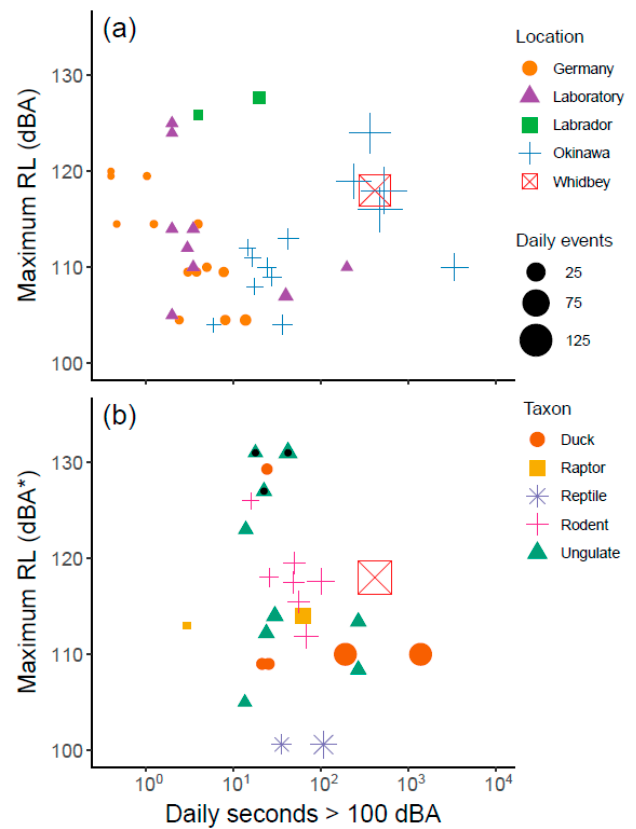
Figure 7. Maximum received level (RL), cumulative daily duration in seconds > 100 dBA, and the daily number of events in the current study (Whidbey) and previous studies of impacts of military low-altitude flights (Table S1) related to ( a ) people and communities and ( b ) wildlife. Colored symbols reflect ( a ) geographic region and ( b ) broad taxonomic group, with the daily number of events represented by the size of the symbol. Maximum received levels in studies were typically reported as A-weighted sound pressure levels (dBA) or dBA could be calculated, ( * ) with the exception of 3 data points from wildlife studies (black dot inside symbol) that exclusively reported either C-weighted sound pressure levels or A-weighted sound exposure level (Table S1); the exceptions were included as these metrics are expected to overestimate RL (dBA).